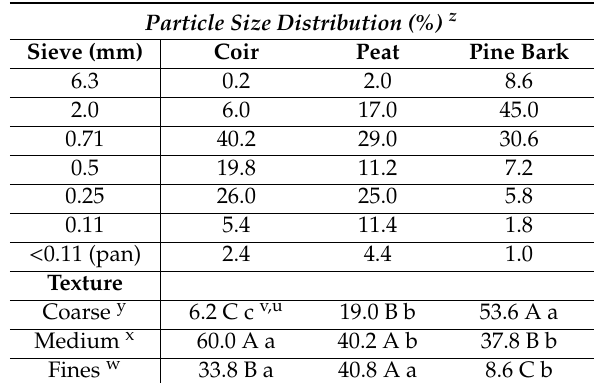
Table 1. Particle size distribution of three traditional greenhouse substrate